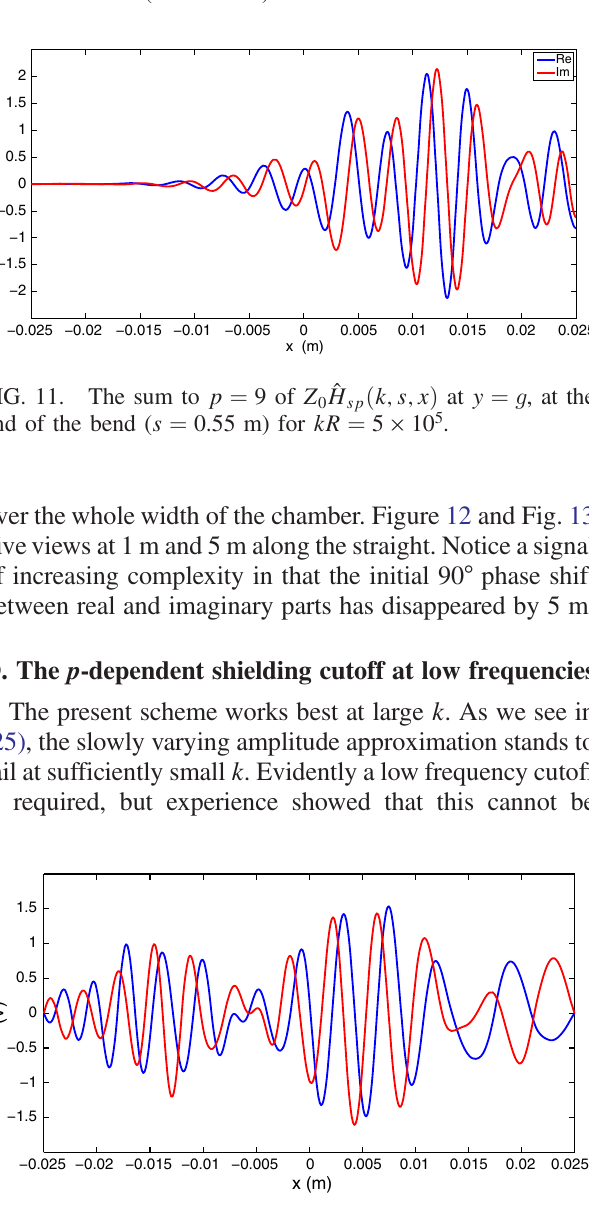
FIG. 9. The sum to p ¼ 9 of the bend ( s ¼ 0 . 55 m) for kR ¼ 5 × 10 5 .